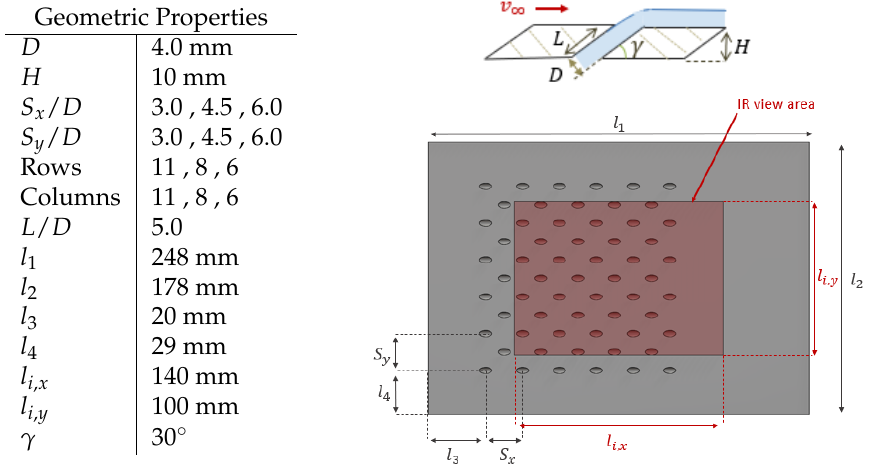
Figure 1. A schematic showing the dimensions of the flat plate geometry, where the red section highlights the visible portion for the IR camera. The illustration here shows the S x / D = S y / D = 6.0 geometry.